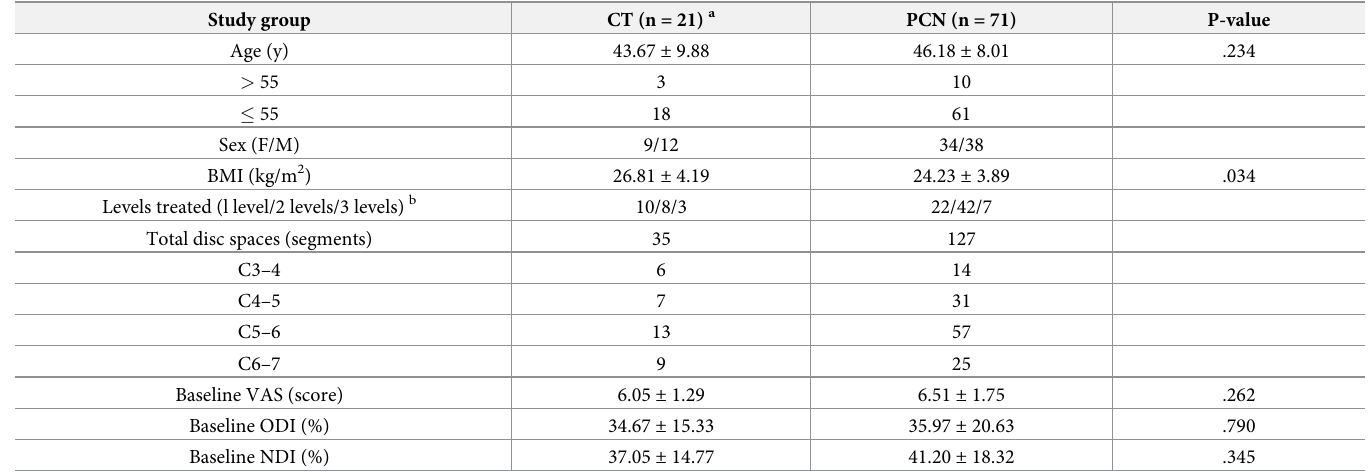
Table 1. Demographic